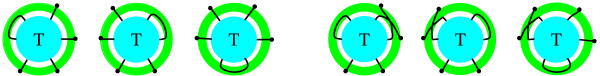
2-string tangle analysis will be used to determine these 2-string tangles from Fig. 6. The ends of the two strings are marked by dots.